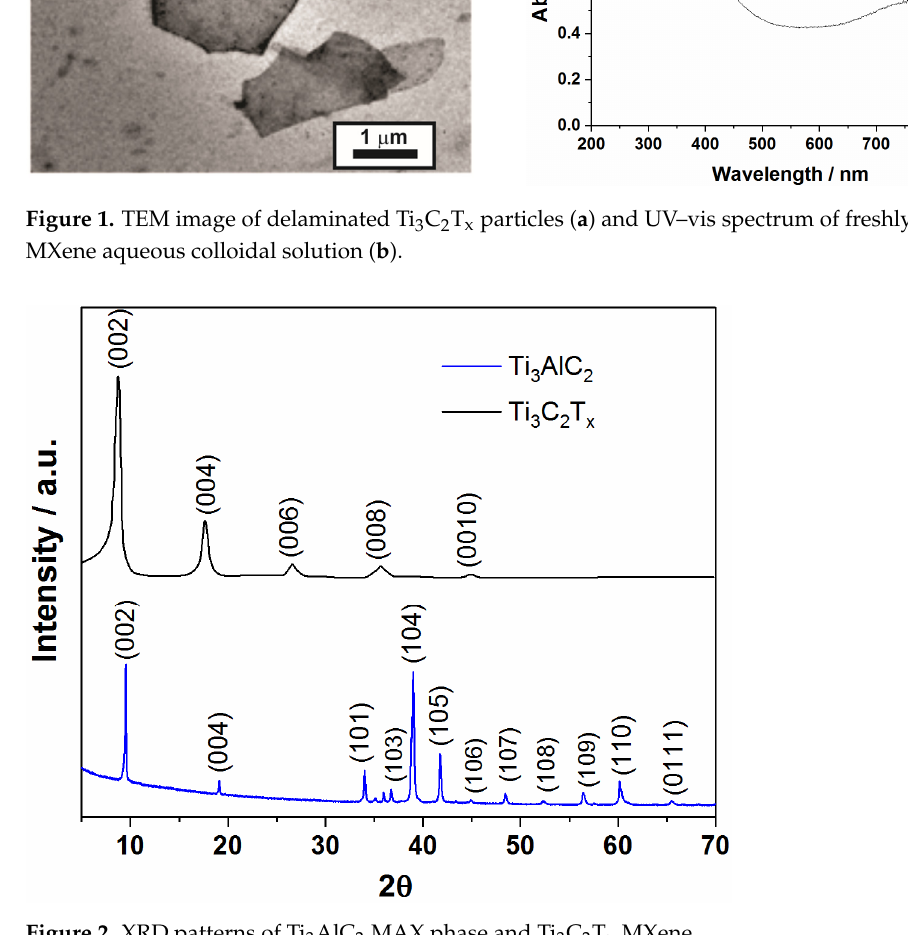
Figure 1. TEM image of delaminated Ti 3 C 2 Т х particles ( a ) and UV–vis spectrum of freshly prepared MXene aqueous colloidal solution ( b ).